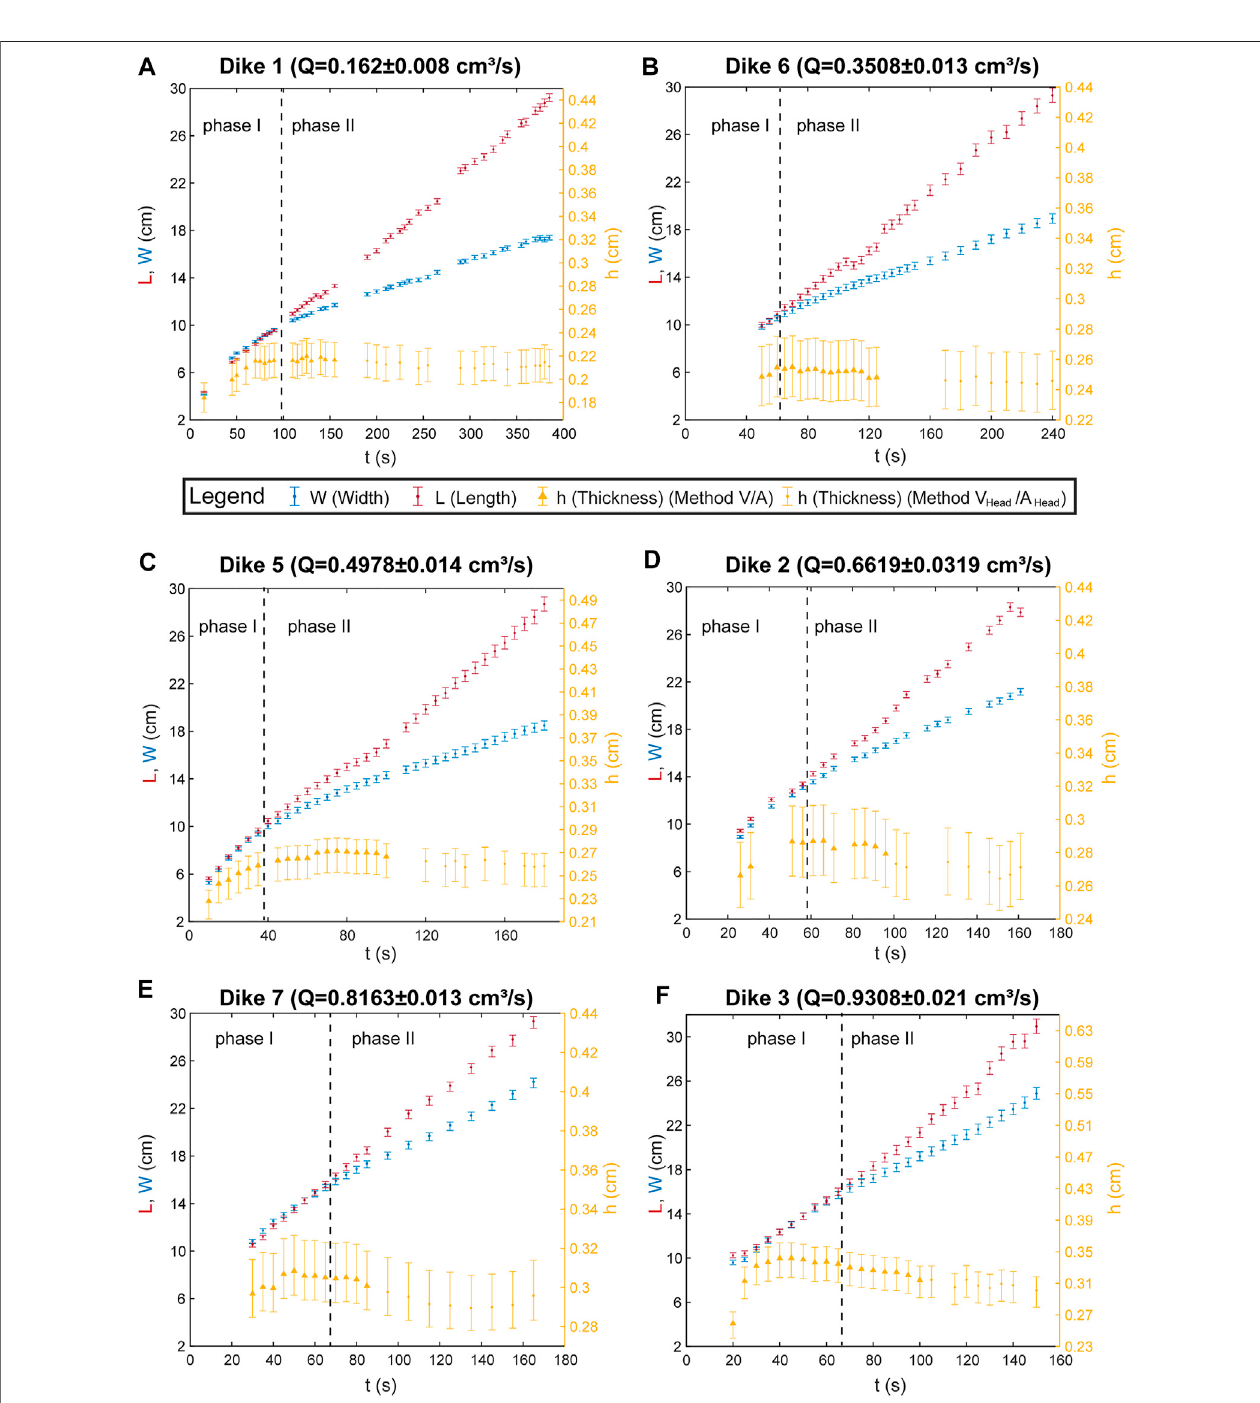
FIGURE 3 | Temporal variation of the width (W), length (L) and thickness (h) in each experiment arranged (A – F) with increasing injection rates. The V/A Method is basedontheratioVolume/Areaappliedinthe fi rstphaseandatthebeginningofthesecondphase.Then,weapplythemethodV head /A head basedontheratioVolumeof the head/Area of the dike